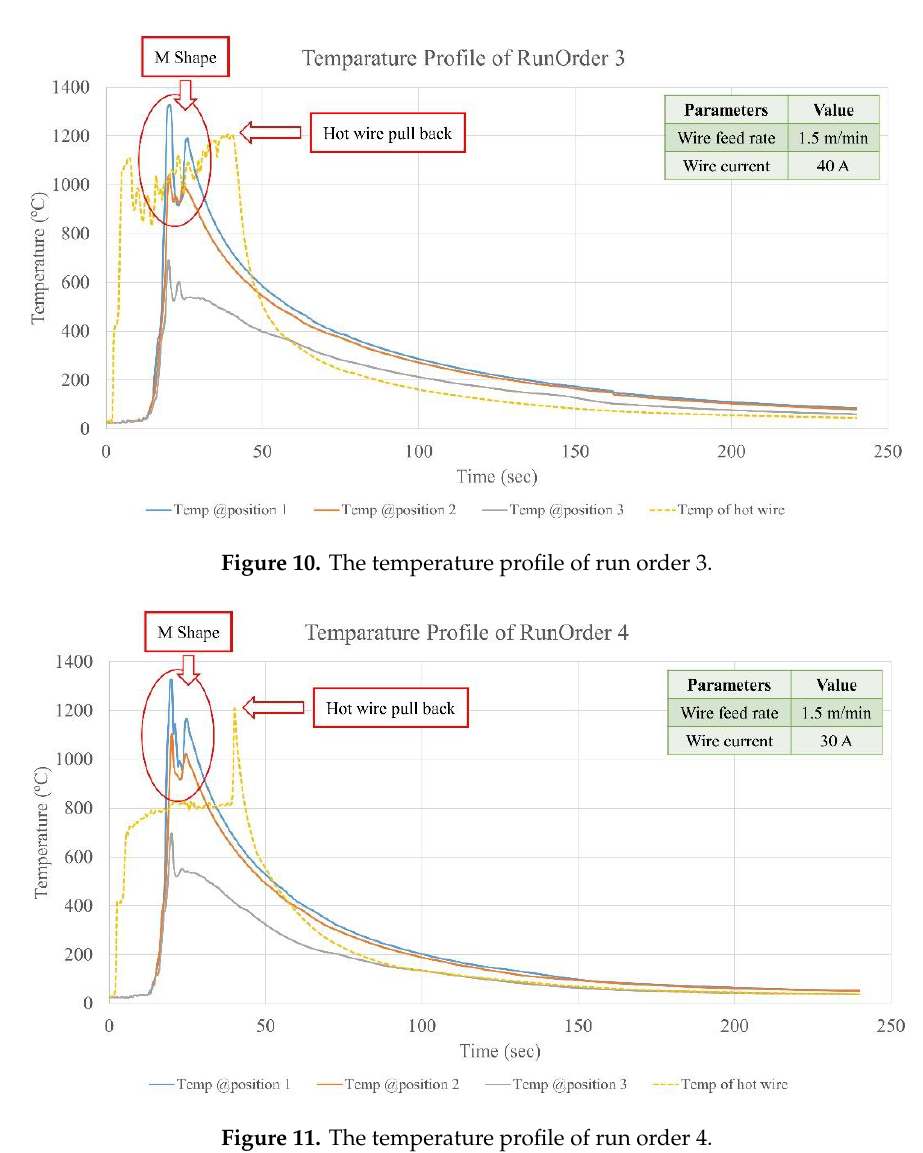
Figure 11. The temperature profile of run order 4.